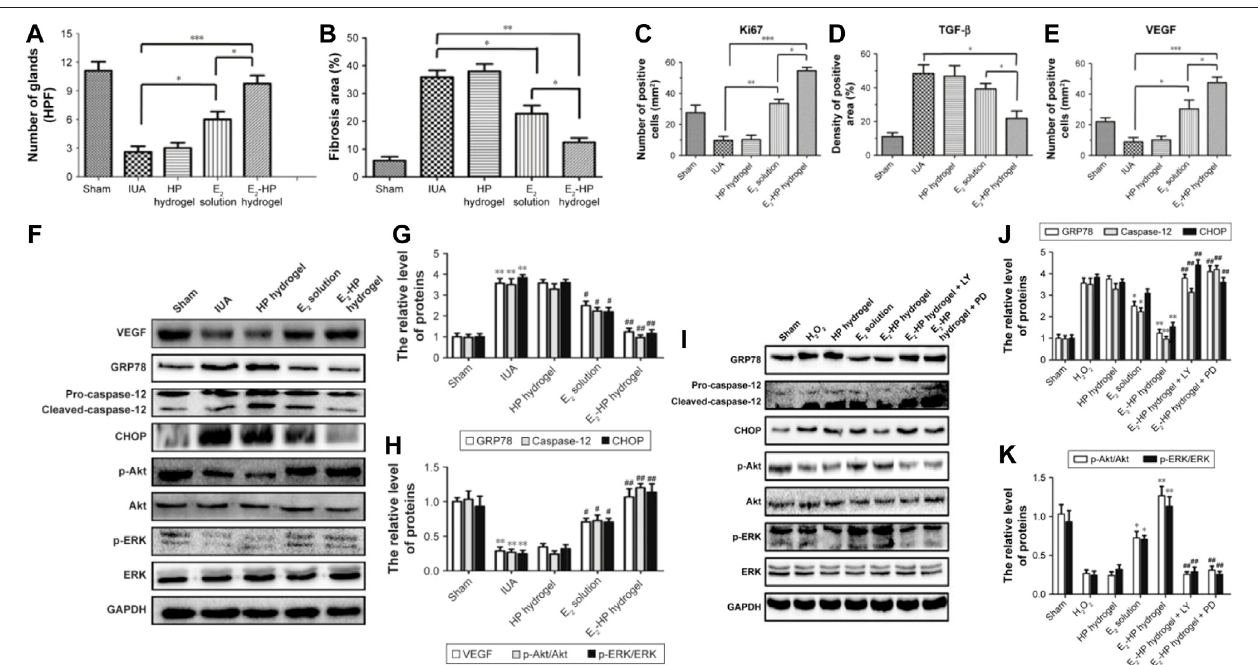
FIGURE5| SchematicdiagramofE 2 -HPhydrogelasan in-situ administrationdrugforthetreatmentofintrauterineadhesions. (A) Analysisofthenumberofglands in each group at 14 days after IUA. (B) Analysis of fi brosis area in endometrium in each group at 14 days after IUA. (C) Analysis of Ki67 positive cells of the immunohistochemistryresults. (D) AnalysisofTGF- β positiveareaoftheimmunohistochemistryresults. (E) AnalysisofVEGF-positive cellsoftheimmunohistochemistry results.Dataarepresentedasmean±standarddeviation;n=5;* p < 0.05,** p < 0.01,and*** p < 0.001.E2-HPhydrogelinhibitsERstressandactivatestheAktand ERK1/2 pathways in the IUA rats. Notes: (F) The protein expressions of VEGF, GRP78, caspase-12, CHOP, p-Akt, and p-ERK in each group were tested with Western blotting. GAPDH was used as the loading control and for band density normalization. (G) The optical density analysis of GRP78, caspase-12, and CHOP protein. ** p < 0.01 versus the Sham group and # p < 0.05 and ## p < 0.01 versus the IUA group. (H) The optical density analysis of VEGF, p-Akt, and p-ERK protein. ** p < 0.01 versus the Sham group and # p < 0.05 and ## p < 0.01 versus the IUA group. The activation of Akt and ERK1/2 is crucial for the protective effect of E2-HP hydrogel in H2O2- inducedERstressinEECs.Notes: (I) TheproteinexpressionsofGRP78,caspase-12,CHOP,p-Akt,andp-ERK1/2inERstress-inducedapoptosisinEECstreatedwith E2-HPhydrogelanddifferentinhibitors.GAPDHwasusedastheloadingcontrolandforbanddensitynormalization. (J) TheopticaldensityanalysisofGRP78,caspase- 12, and CHOP protein. (K) The optical density analysis ofp-AKT and p-ERK protein. * p < 0.05 and ** p < 0.01 versus the H2O2 group and ## p < 0.01 versusthe E2-HP hydrogel group. Data are presented as mean ± standard deviation; n = 3. Reproduced with permission from ref (Zhang et al., 2017). CC BY 4.0. Copyright 2017 The